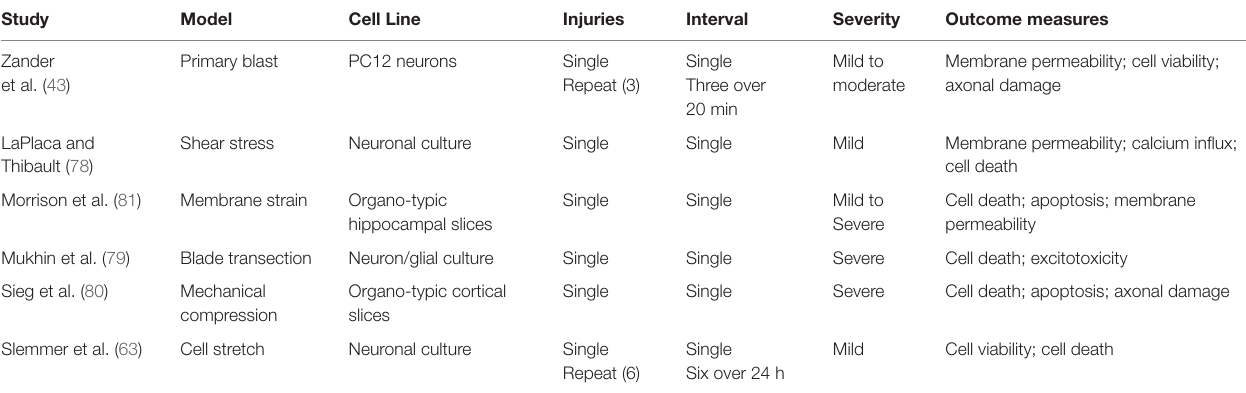
TABLe 7 | In vitro and ex vivo TBi